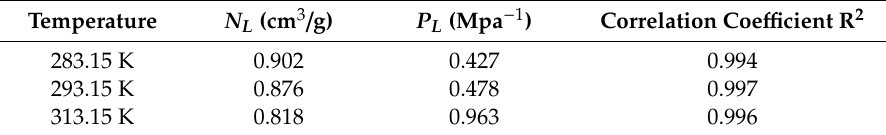
Table 2. Langmuir constants of adsorption of CO 2 at temperatures of 283.15, 293.15, and 313.15